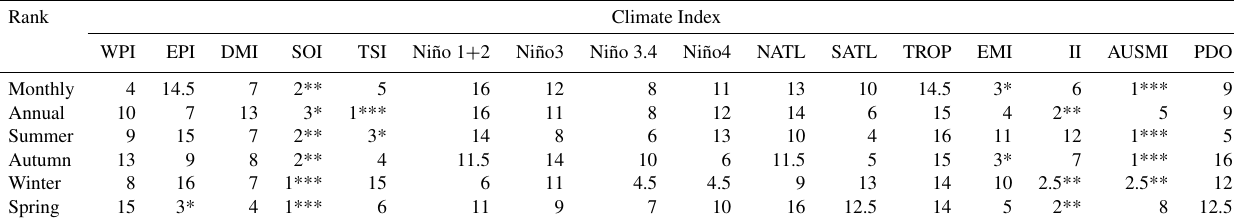
Table 5. Ranks showing relative correlation strengths of each climate index with precipitation over monthly, annual and seasonal time periods. Each rank shows, on average, which climate index has the highest correlation with rainfall at all sites along the NATT from July 1900 to June 2010 (except winter which uses calendar year from 1900 to 2009, not hydrological year). For example, on a monthly timescale AUSMI, on average, is the most highly correlated climate index over the entire NATT, SOI is the second most highly correlated, EMI is the third highest, and so on. Note, this table does not take statistical significance into account. First ***, second ** and third * highest correlations are given a number of asterisks for